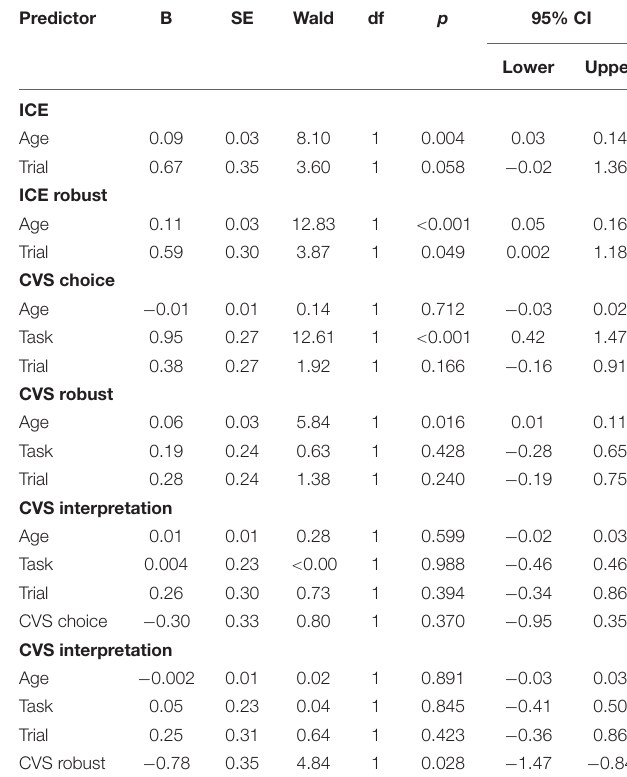
TABLE 4 | Generalized estimating equation model